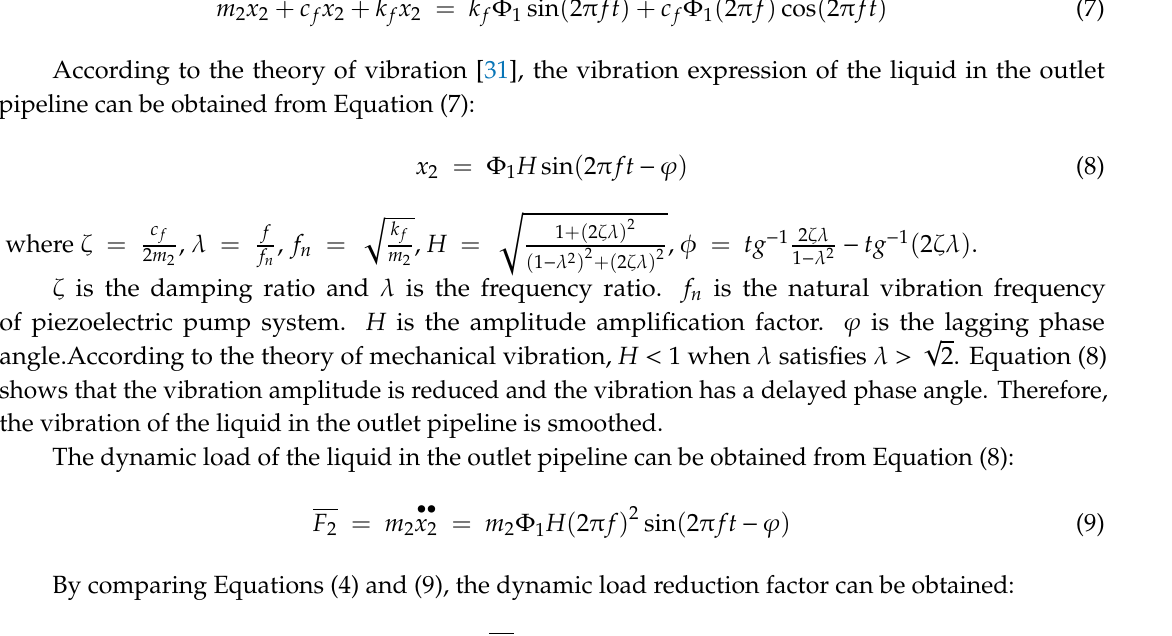
Figure 5. The two-dimensional simulation models.